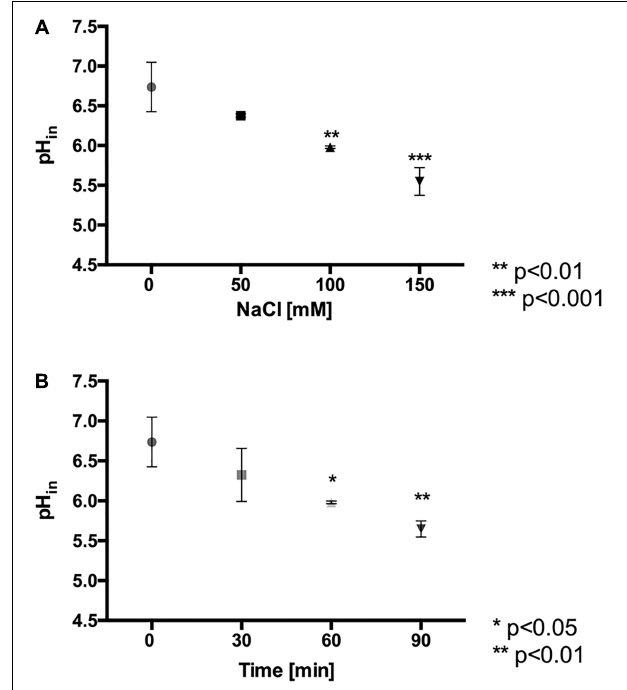
in ) in L. ferriphilum DSM 14647. Effect of NaCl concentration on pH in of cells exposed for 60 min to the stress condition (A) . Effect of the exposure time in cells exposed to 100 mM NaCl (B) . The data represent the average of 3 independent experiments (bars indicate the value range). Statistical analysis was carried out by ANOVA